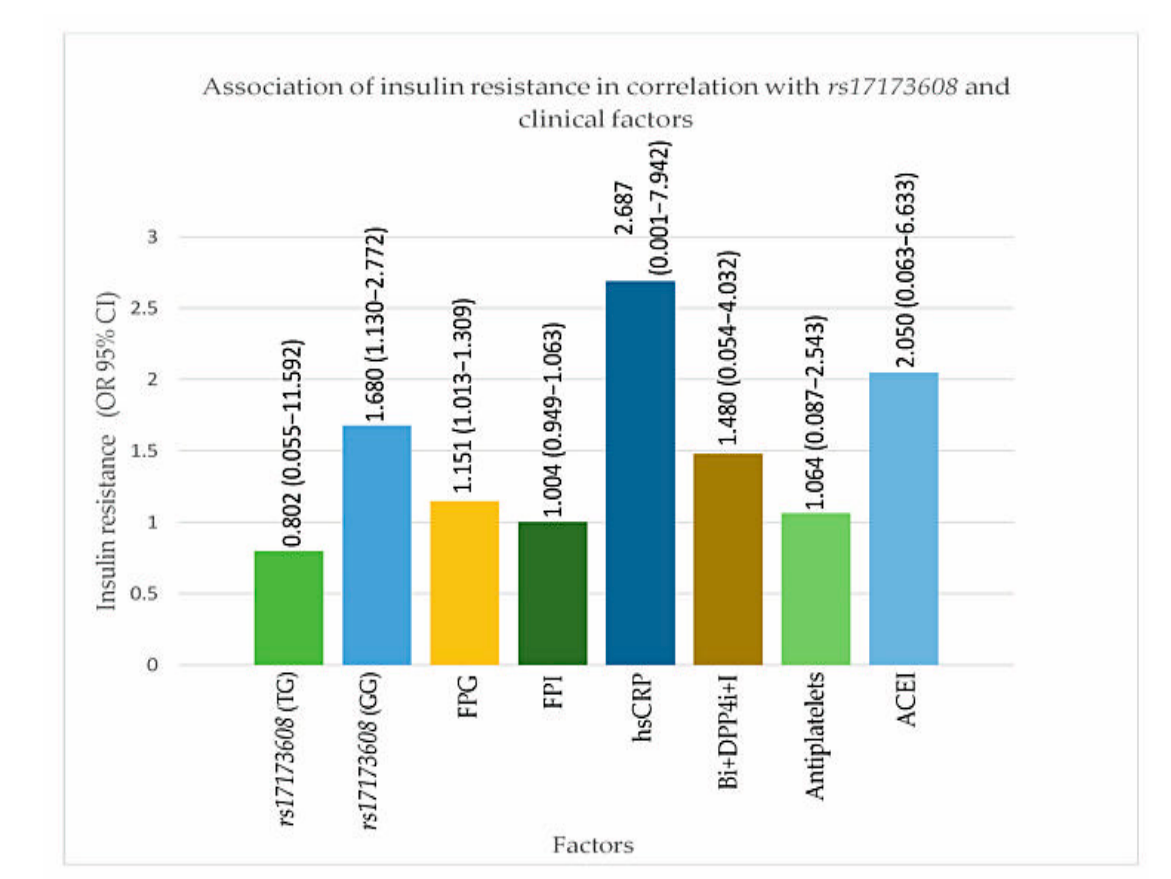
Figure 3. Association of insulin resistance in correlation with rs17173608 and clinical factors. FPG: Figure 4. i: dipeptidyl peptidase-4 inhibitor; I: insulin. OR: odds ratio; CI: confidence interval. Table 6. Associations of severity of CAD in correlation with rs17173608 and clinical factors.